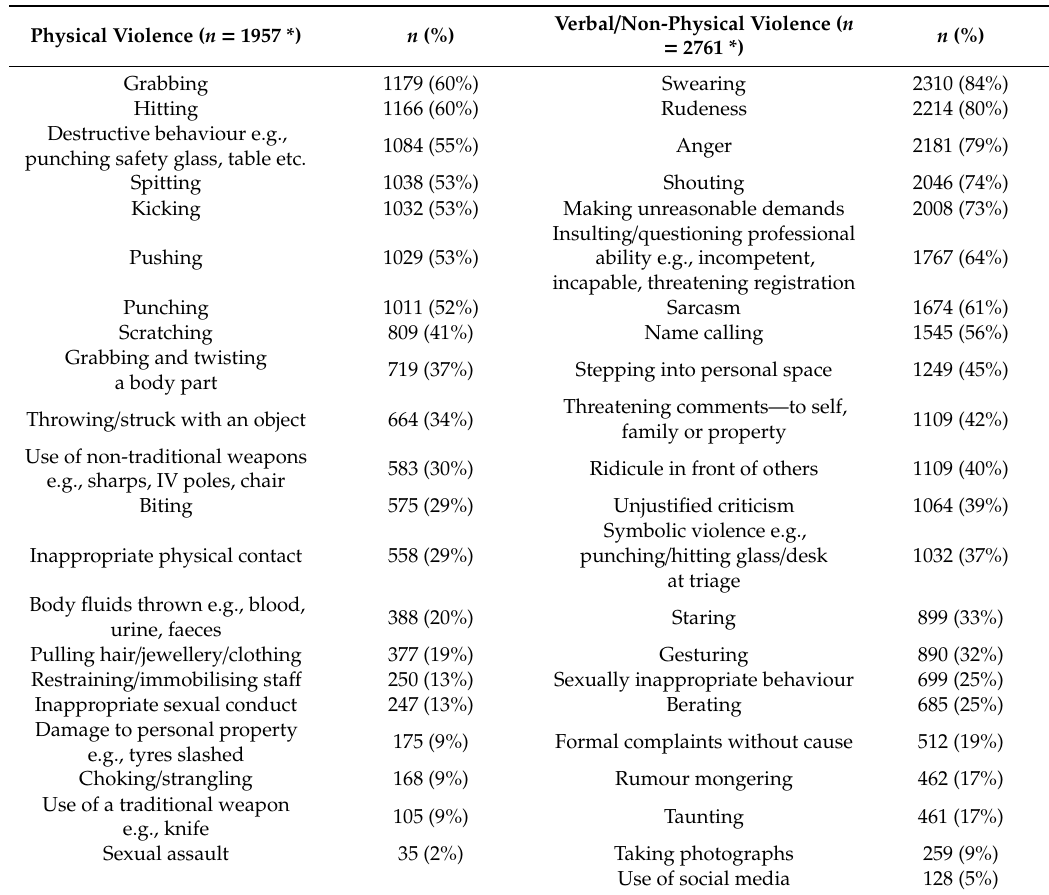
Table 2. Types of